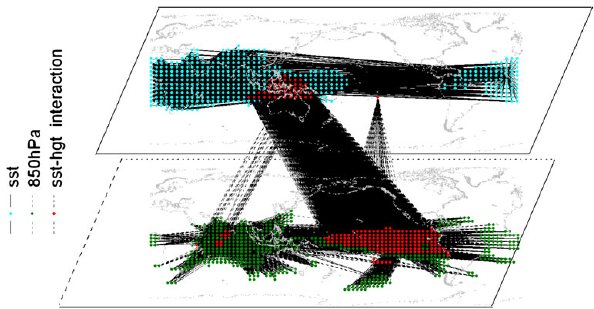
Figure 9. Two-layered network visualisation; © Springer, reprinted from Feng et al. (2012); original caption: “The graph of bilayer air– sea interaction networks: the dots with olive colour and cyan colour represent the nodes with weighted node degree greater than 0.18 for the lower layer subnetwork and 0.14 for the upper layer sub- network, respectively. The red dots represent the cross nodes with weighted node degree greater than 0.06. The black dashes or solid lines represent